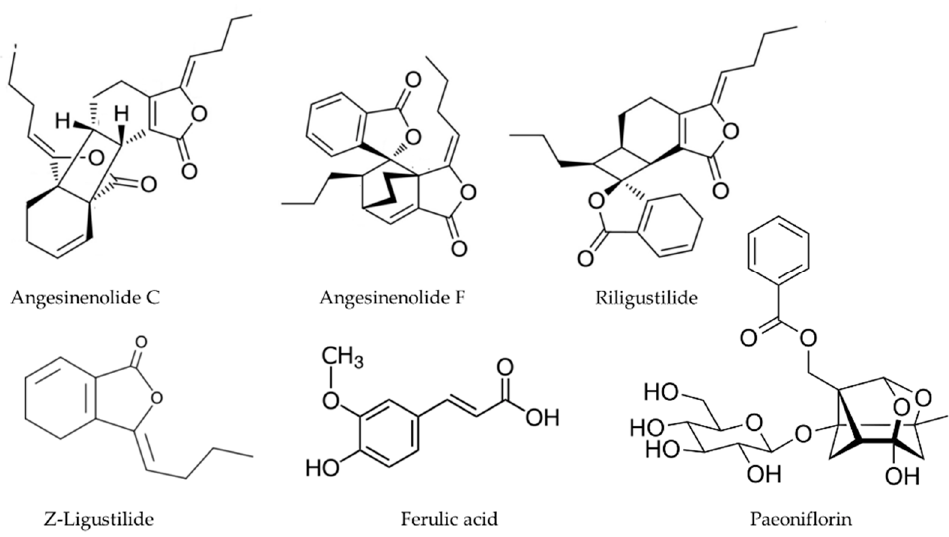
Figure 4. Bioactive anti-inflammatory (eicosanoid inhibition) and antioxidant principles from A. sinensis.